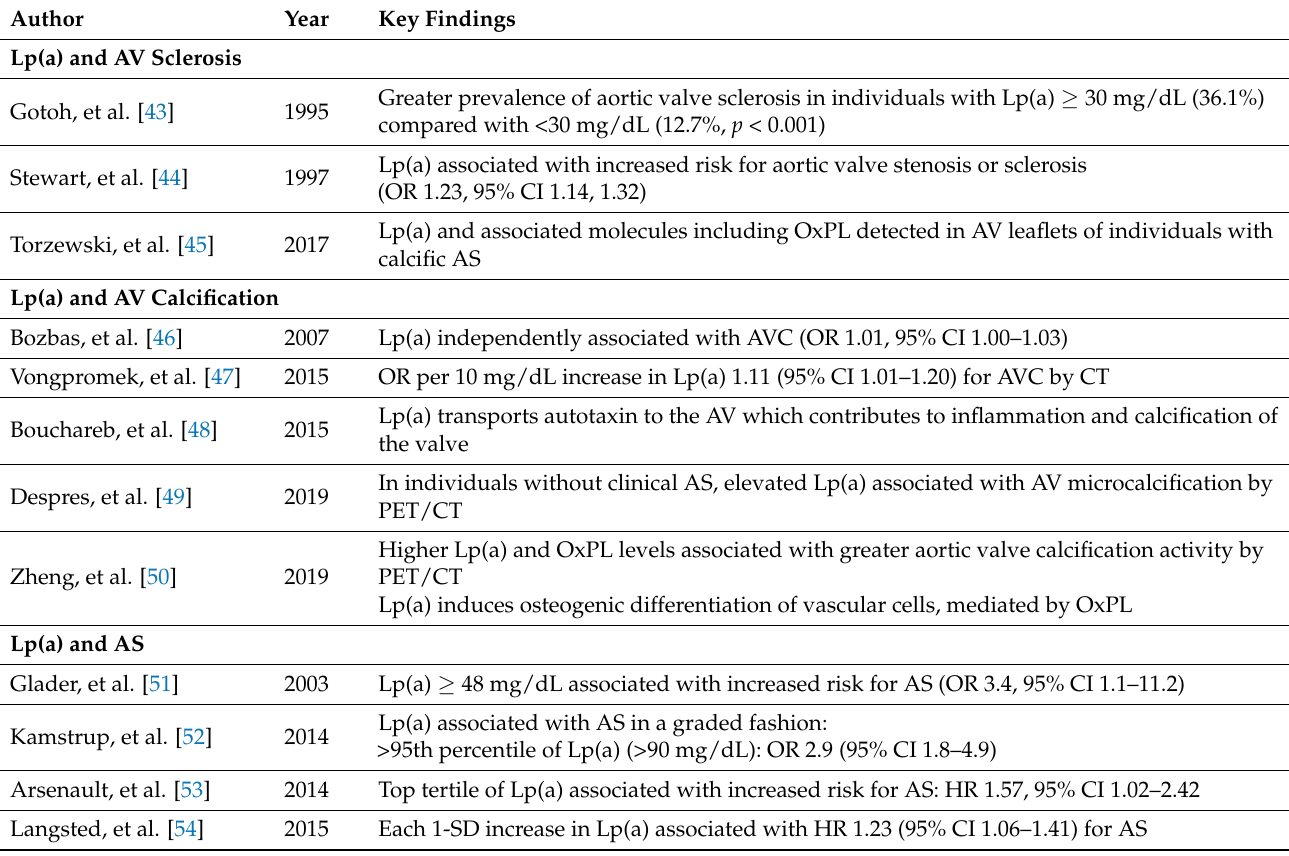
Table 2. Key studies of Lp(a) as a risk factor for calcific aortic valve